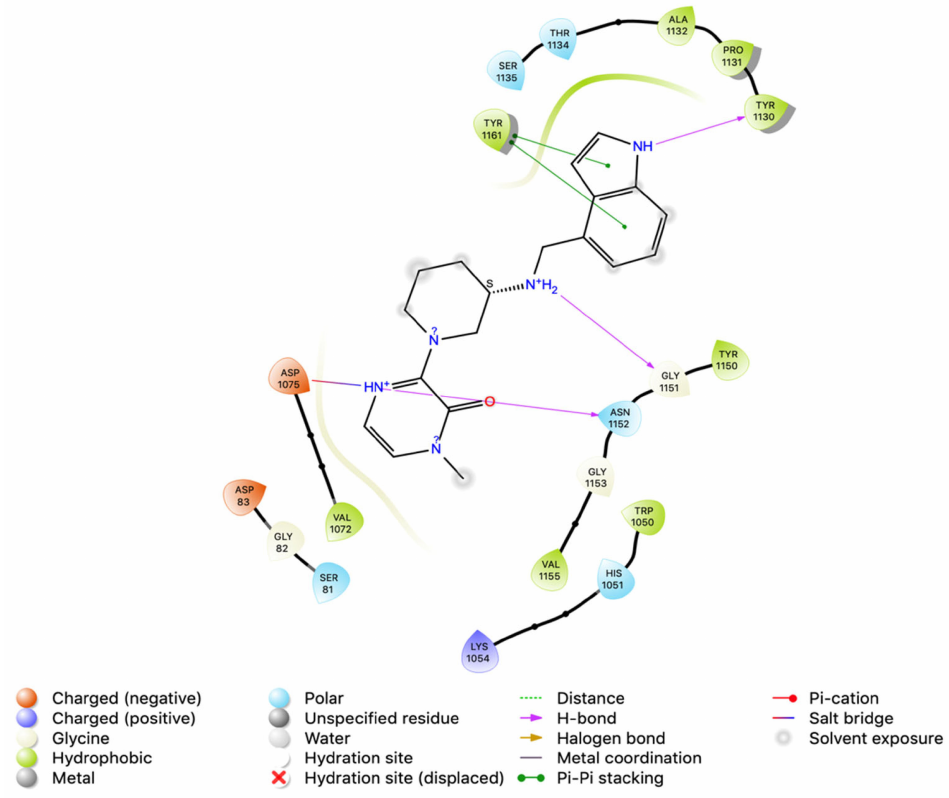
Figure 3. Interactions analysis of comp 2 with NS2B-NS3 protein of Zika